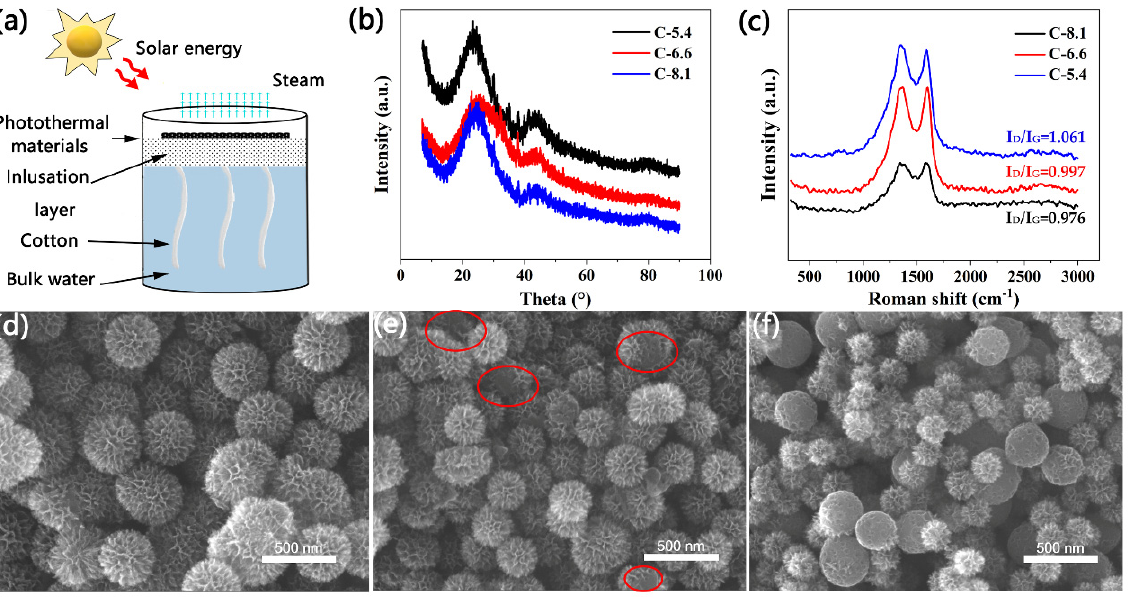
Figure 1. ( a ) Schematic illustration of the solar evaporation experimental device. ( b ) XRD patterns of C-5.4, C-6.6, and C-8.1 carbon nanomaterials. ( c ) Raman spectra of C-5.4, C-6.6, and C-8.1 samples. ( d ) SEM surface image of the C-5.4 carbon nanomaterials. ( e ) SEM surface image of the C-6.6 carbon nanomaterials. ( f ) SEM surface image of the C-8.1 carbon nanomaterials.